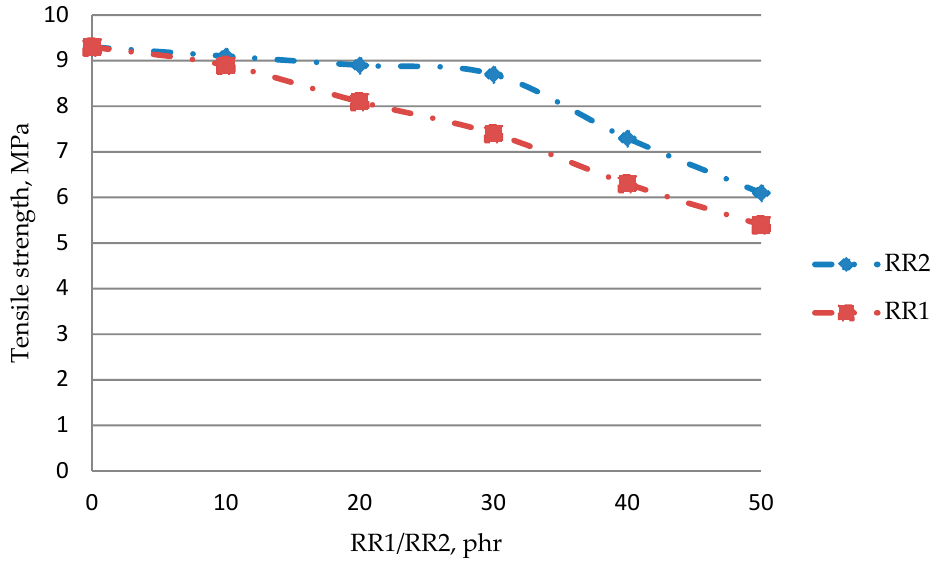
Figure 6. Evolution of tensile strength according to the percentage of reclaimed rubber used to make the samples.